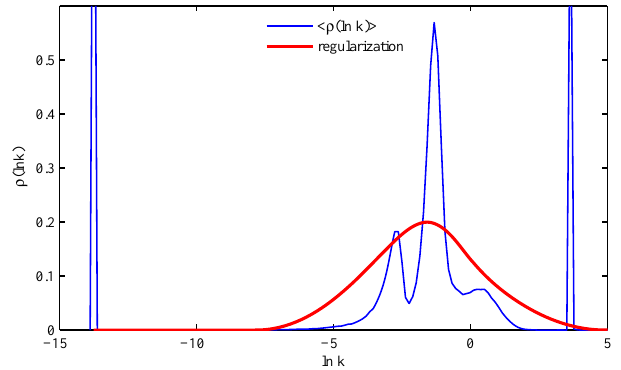
Fig. 4. The average (blue) of all 60000 noise-generated multi-pool solutions from Fig. 2 plotted alongside the regularized solution (red). h ρ( ln k) i is calculated by summing ρ from all 60000 noise- generated trials and dividing the sum by 60000.